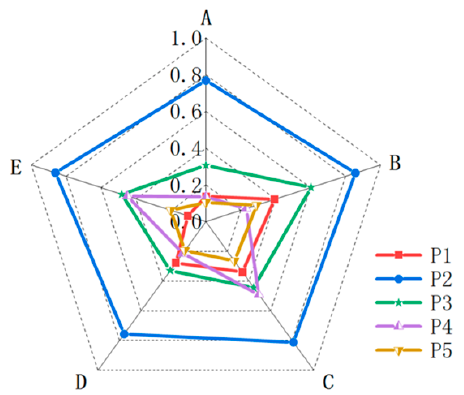
centre thickness of the forging were taken to obtain the residual stress magnitude, and the residual stress reduction rate was calculated (Figure 13).